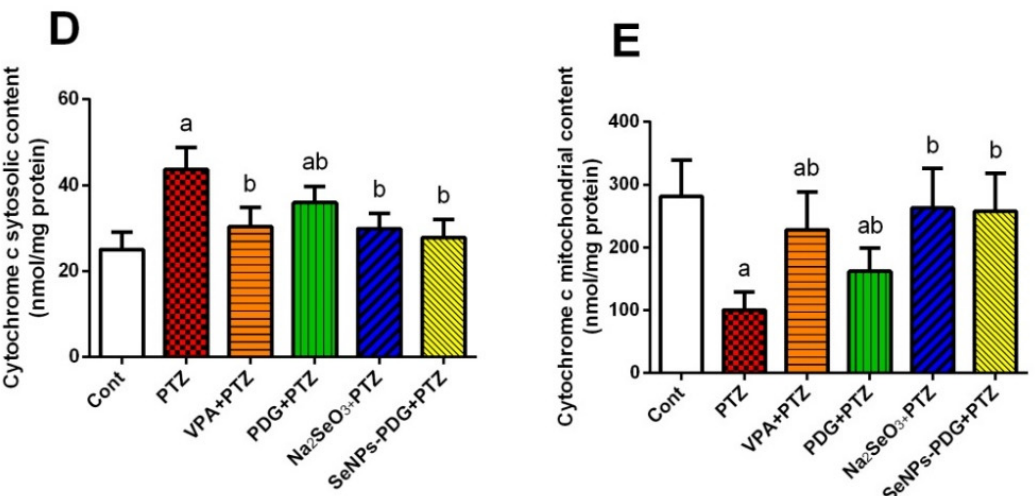
Figure 4. Effects of orally administered prodigiosin (PDG), sodium selenite (Na 2 SeO 3 ), and green biosynthesized SeNPs with PDG (SeNPs-PDG) on the levels of apoptosis markers, including ( A ) caspase-3, ( B ) Bax, ( C ) Bcl-2, ( D ) mitochondrial cytochrome c, and ( E ) cytosolic cytochrome c in hippocampal tissue following pentylenetetrazole (PTZ)-induced epileptic seizures. a and b denote significant differences ( p < 0.05) compared with the untreated control and PTZ-injected groups, re- spectively. All results are presented as the mean ± standard deviation (SD).